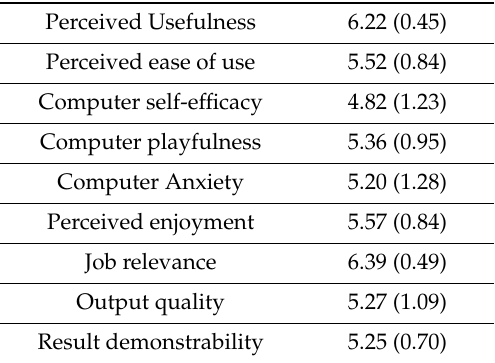
Figure 11. A representation of System Usability Scale (SUS) score; a score between 75 and 85 ranges from “Good usability” to “Excellent usability”. Table 3. A re-capitulatory table illustrating the results of the dashboard’s testing with Technology Acceptance Model (TAM) subscales. For each subscale (listed in the left columns), the mean score obtained and the standard deviation (in brackets) are presented.